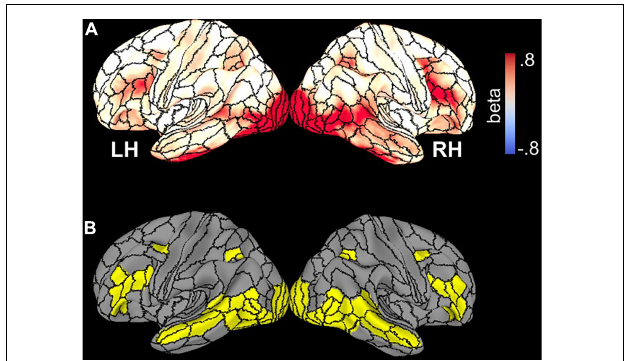
FIGURE 2 | (A) Whole-brain beta parameter maps of activation elicited by all stimuli and across all participants, superimposed on the template brain with borders of HCP parcels demarcated. (B) Thirty-five parcels with significant activation collapsed across subjects and face